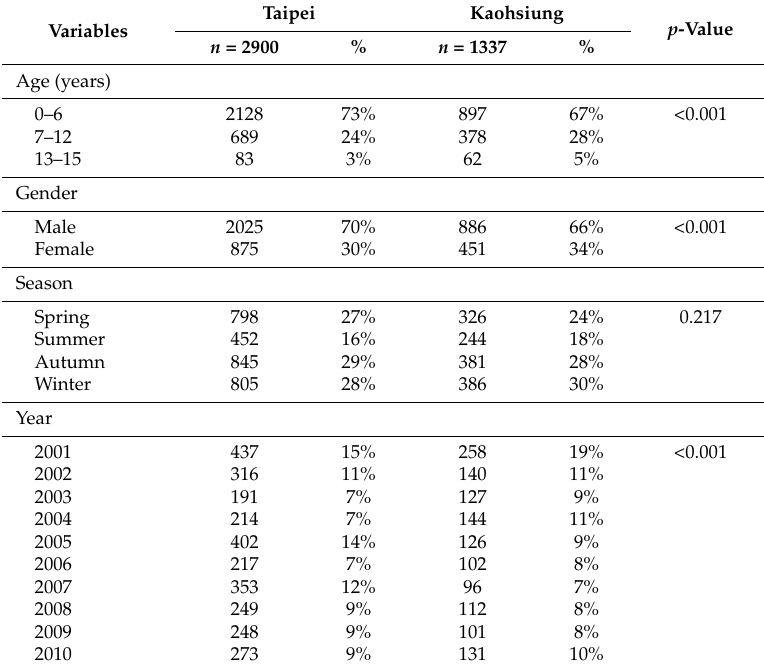
Table 1. Hospitalization characteristics.